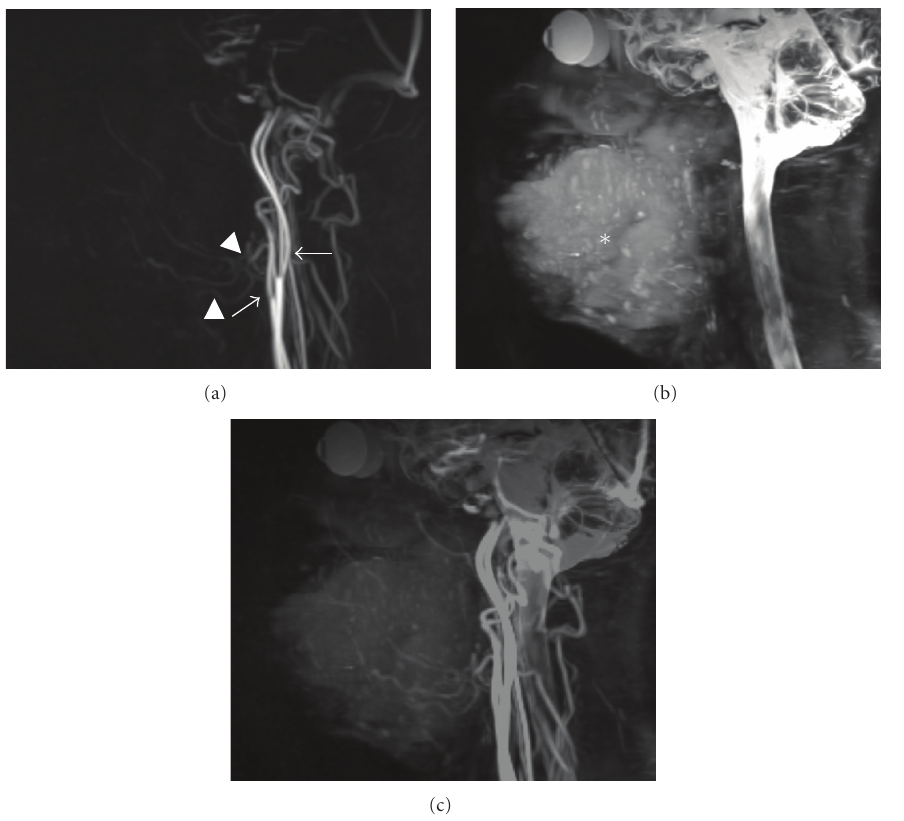
Figure 4: The production of a superimposed view of MRA using 3D-PC and a T2-weighted image in a 46-year-old patient with multiple hemangiomas of the bilateral tongue, lower lip, cheek, oral floor, masticator space, and right parotid space. (a) On MRA using 3D-PC, the external (arrow) and internal carotid arteries (black arrow), and the facial (arrowhead) and lingual arteries (black arrowheads) are shown, but the hemangiomas in the orofacial area are not seen. Acquisition time was 10 minutes and 15 seconds. (b) Fat-saturation T2-weighted image using 3D-FASE sequences of the head and neck. A hemangioma is visualized on this image (star). Acquisition time was 5 minutes and 8 seconds. (c) On fusing fat-saturation T2-weighted images with MRA by 3D-PC, hemangiomas and surrounding vessels can be visualized. However, image resolution of the fusion image is degraded compared to that of MRA using